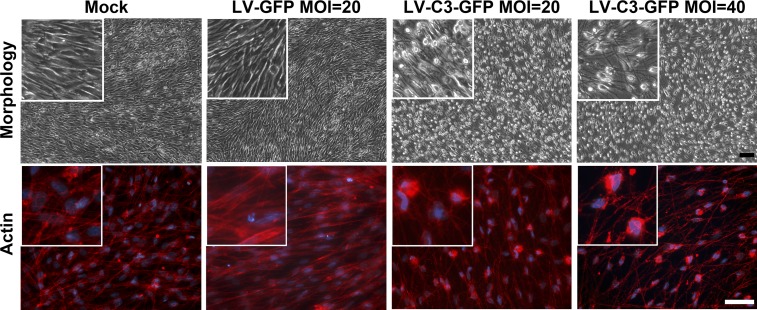
Actin organization in confluent 6-well plate monolayers of HTM cells 48 hours after transduction with lentivirus vectors. Actin was labeled with rhodamine-phalloidin (red fluorescence) and cell nuclei were labeled by DAPI (blue). Compared to LV-GFP–treated (MOI = 20) and medium-only–treated (mock) HTM cells, significant cell rounding and actin reorganization (enlarged inset images) were found in the cells receiving LV-C3-GFP (MOIs = 20 or 40). Black scale bar: 100 μm. White scale bar: 50 μm. The percentage of cells in each condition exhibiting actin disruption is shown in Table 1.